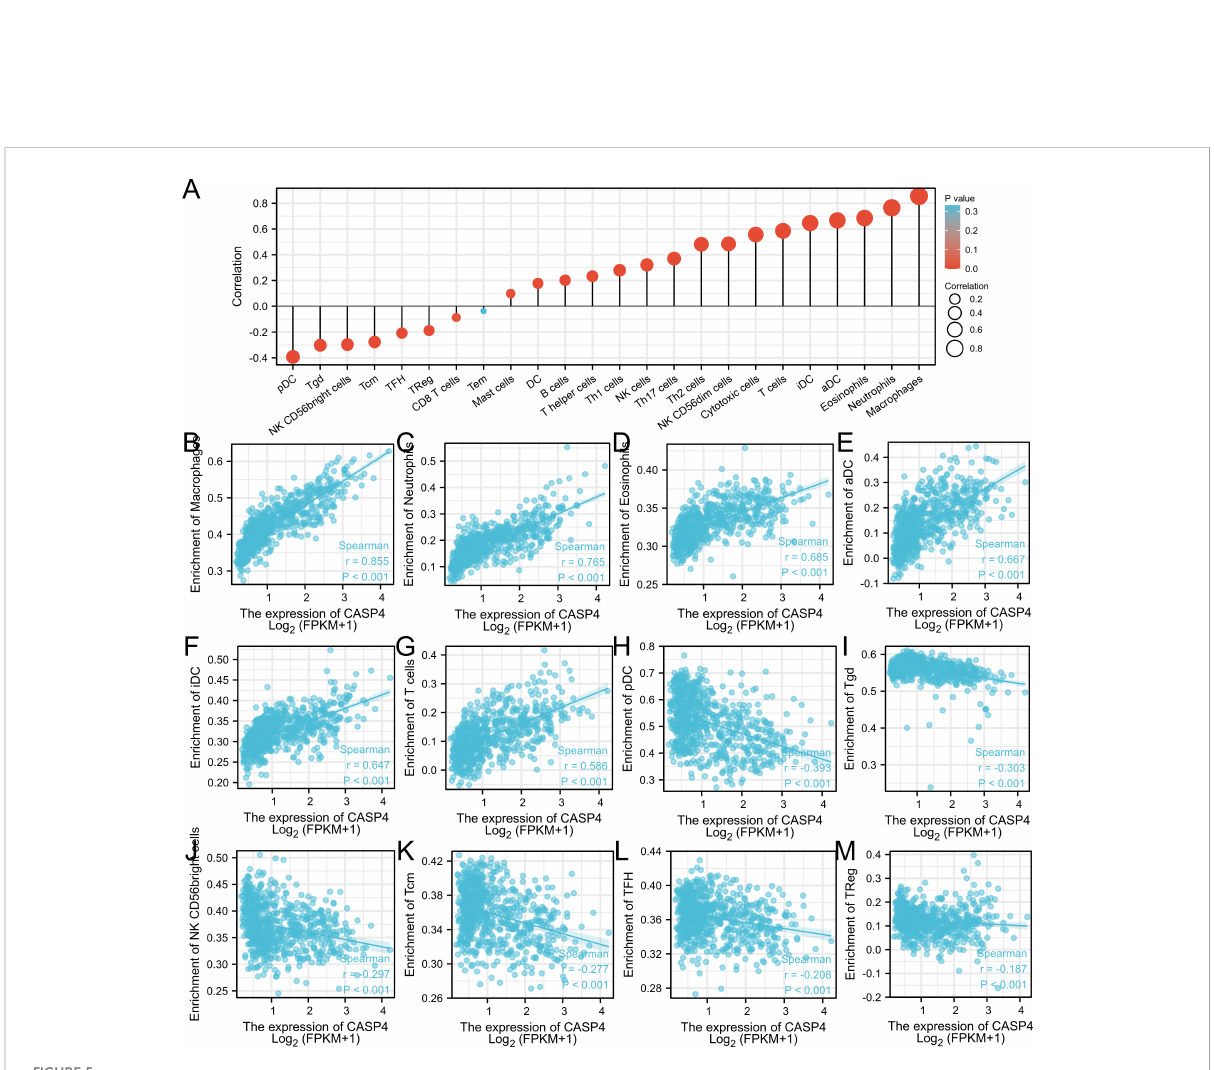
FIGURE 5 Comparison of immune in fi ltration in The Cancer Genome Atlas cohort. (A) Correlation between in fi ltrating immune cell types in gliomas and CASP4 expression. (B – G) Scatter plot of in fi ltrating immune cells showing positive correlations with CASP4 expression. (H – M) Scatter plot of in fi ltrating immune cells showing negative correlations with CASP4